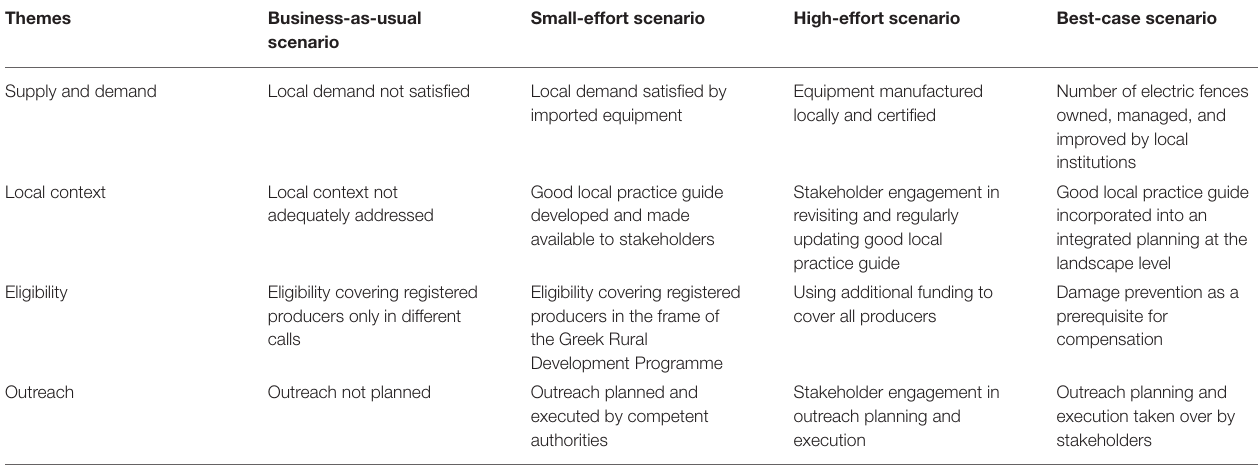
TABLE 6 | Template for participatory scenario development for electric